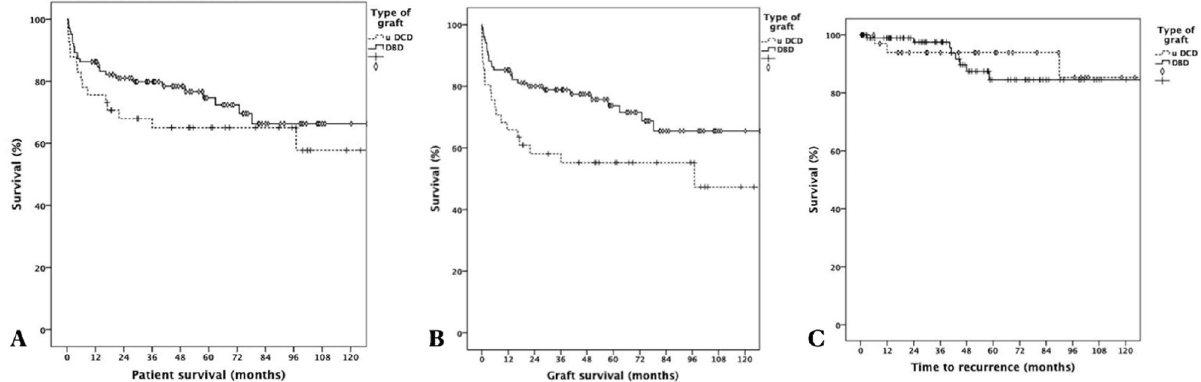
Figure 1. ( A) Patient survival: 1-, 3- and 5-year were 85%, 78% and 72%, respectively, in DBD recipients and 72%, 65% and 61%, respectively, in uDCD recipients ( p = 0.249). ( B) Graft survival: 1-, 3- and 5-year were 84%, 77%, and 71%, respectively, in DBD recipients and 65%, 58% and 58%, respectively, in uDCD recipients ( p = 0.021 ). ( C ) Recurrence-free tumor survival: 1-, 3- and 5-year were 98%, 95% and 82%, respectively, in DBD recipients, and 91%, 79% and 79%, respectively, in uDCD recipients ( p =